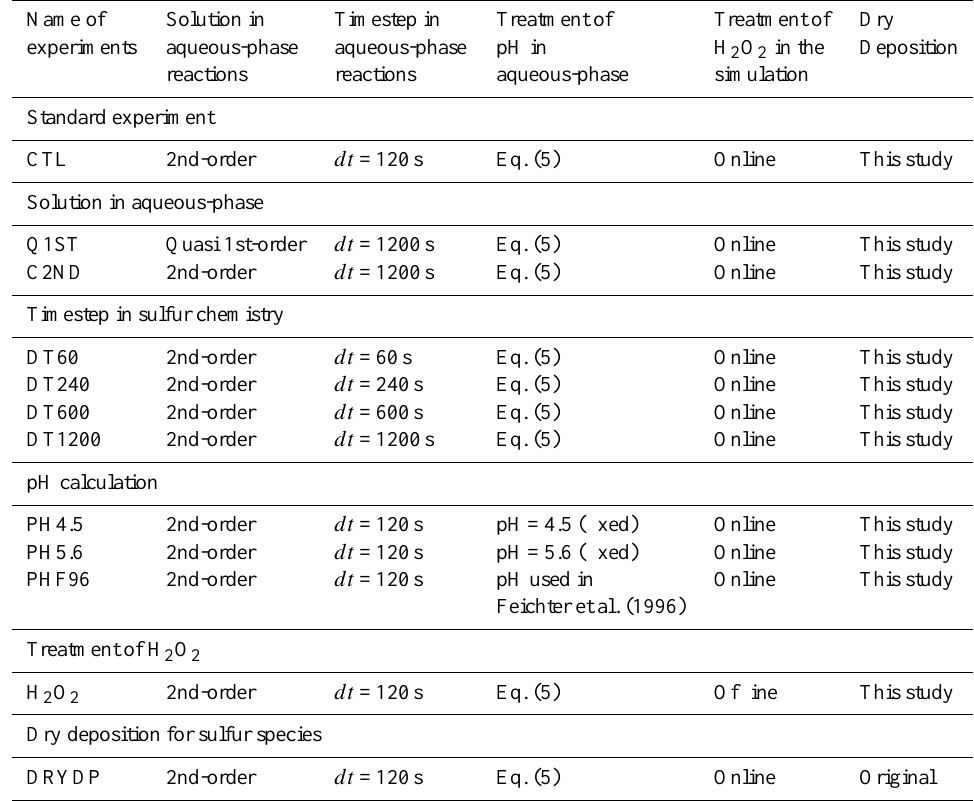
Table 3. Experimental designs of comparison using original and improved